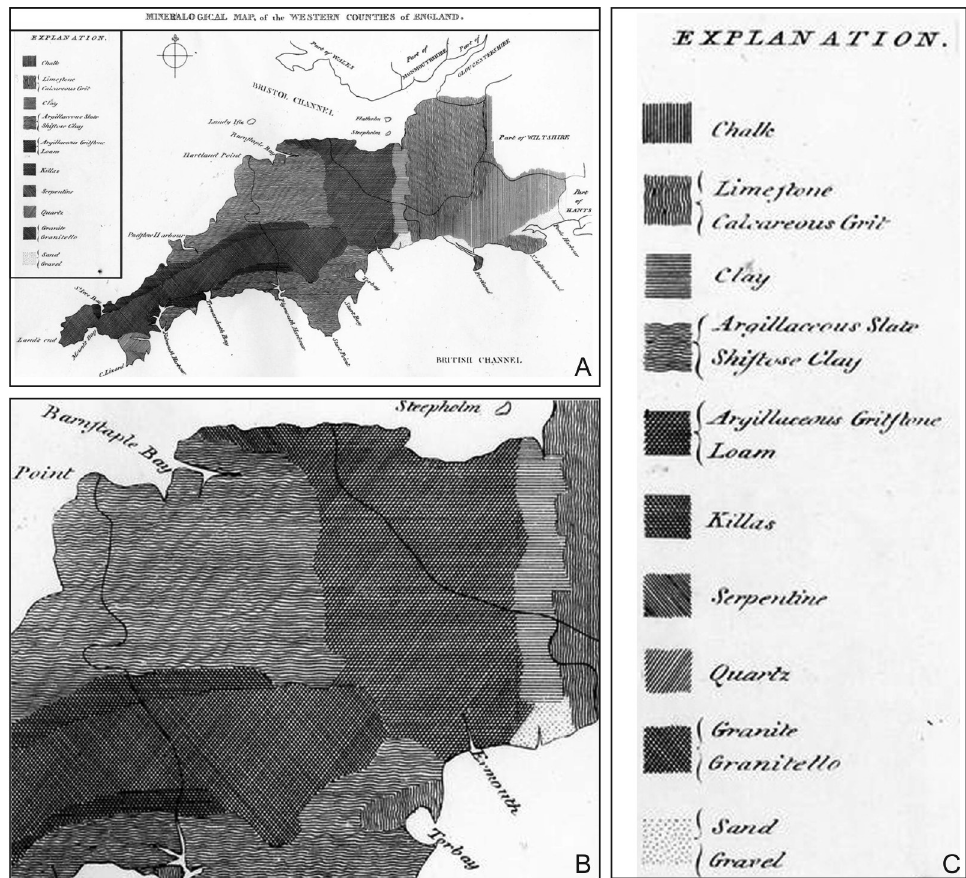
Fig. 2. Mineralogical Map of the Western Counties of England , published by W.G. Maton in 1797 − A, the middle part − B and its explanation − C (from the collection of the Princeton